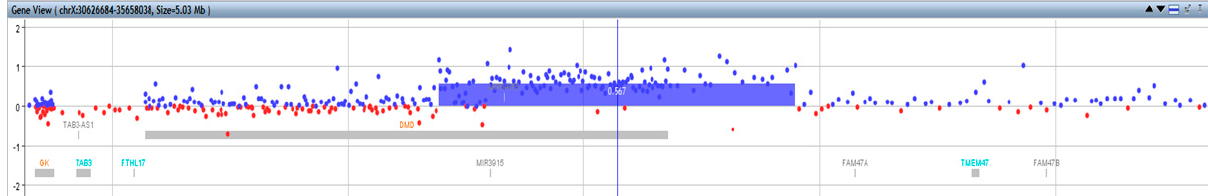
Figure 2. Array CGH + SNP analysis. Blue and red dots correspond to Log 2 positive or negative ratio values (Y-axis) for each probe present in this specific chromosome interval (X-axis). Array CGH + SNP profile of maternal aunt (II-3): a duplication of about 1.51 Mb was detected with 133 probes (highlighted with a blue box). The duplicated region includes the first 34 exons of the DMD gene but also the 0.5Mb 5 ′ region.